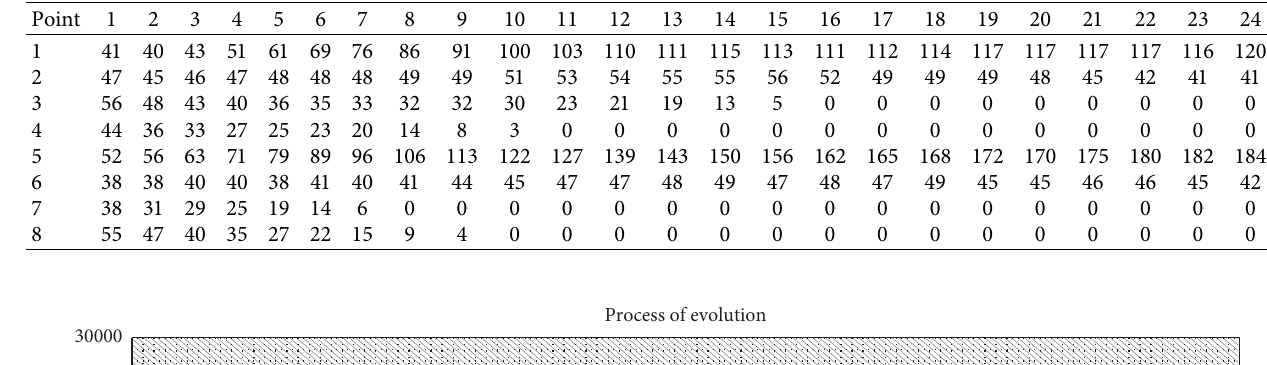
Table 3: Numbers of bikes for each period without scheduling.